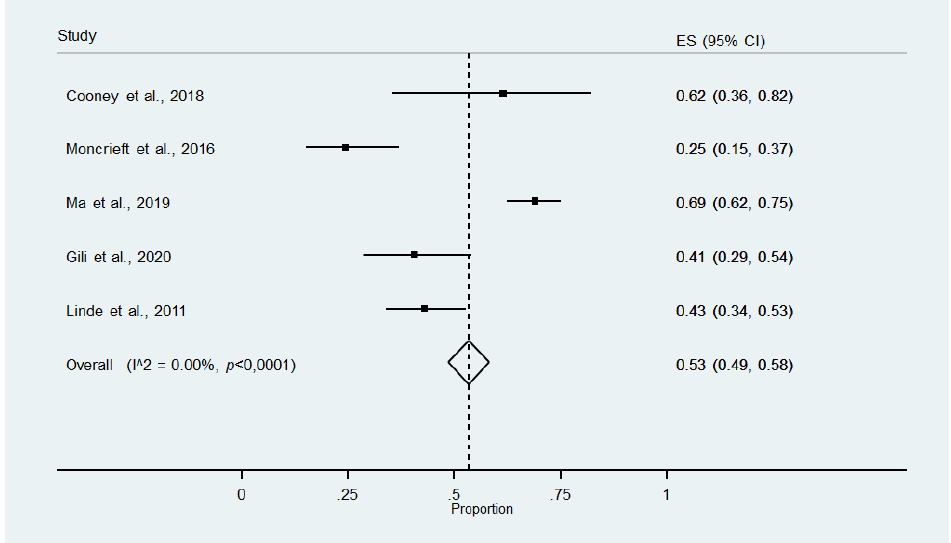
Figure 3. Meta-analysis of intervention completers.